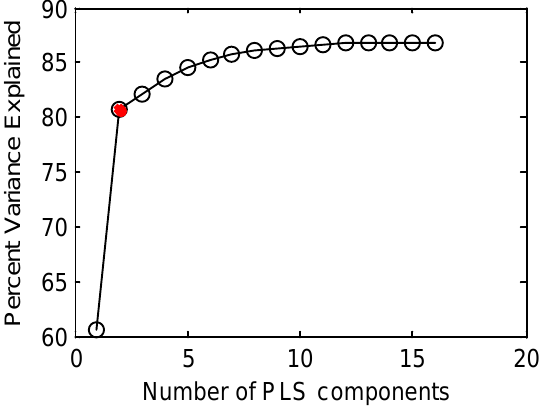
Figure 16. Number analysis of PLS components under fault 8.